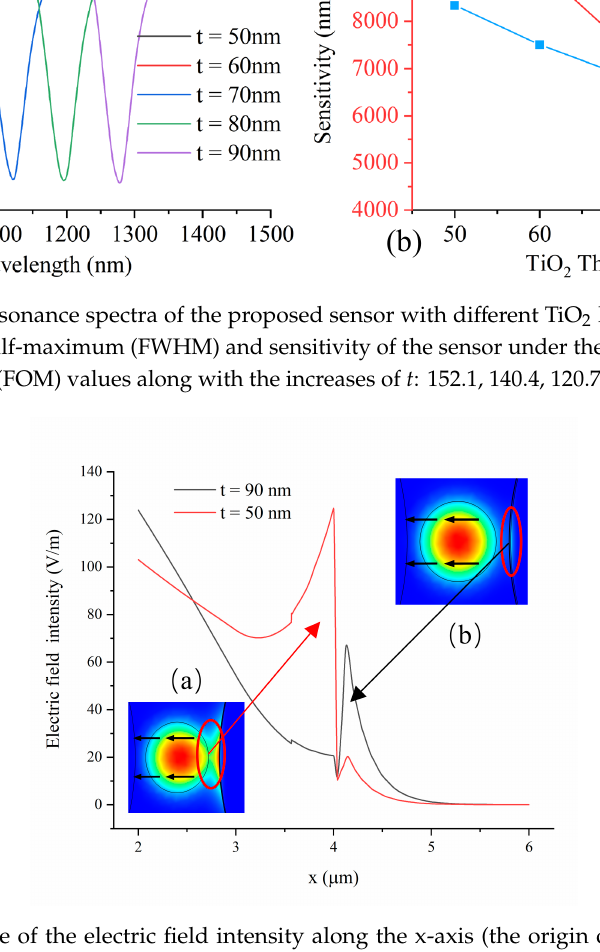
Figure 7. The curve of the electric field intensity along the x-axis (the origin of the coordinates is situated at the center of the core). Insets: ( a , b ) represent the electric field distributions around the liquid core when t = 50 nm and 90 nm, respectively.